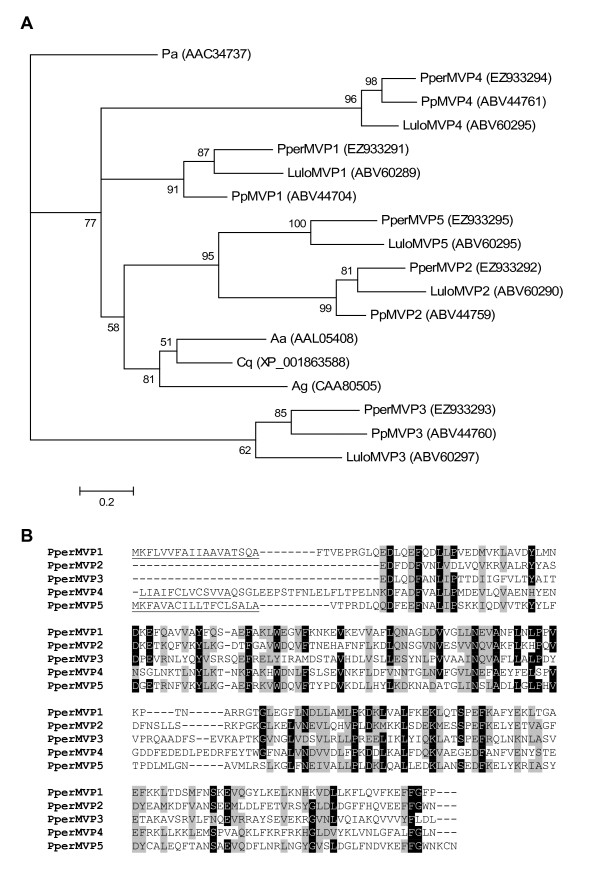
Phylogenetic analysis and sequence alignment of putative microvillar proteins. (A) Periplaneta americana (Pa), Phlebotomus perniciosus (Pper), Phlebotomus papatasi (Pp), Lutzomyia longipalpis (Lulo), Aedes aegypti (Ae), Culex quinquefasciatus (Cq) and Anopheles gambiae (Ag). Accession numbers are given in parentheses. Node support is indicated by the bootstrap values. (B) Phlebotomus perniciosus (Pper). The predicted signal peptides are underlined. Accession numbers: PperMVP1 [GenBank:EZ933291], PperMVP2 [GenBank:EZ933292], PperMVP3 [GenBank:EZ933293], PperMVP4 [GenBank:EZ933294], PperMVP5 [GenBank:EZ933295].